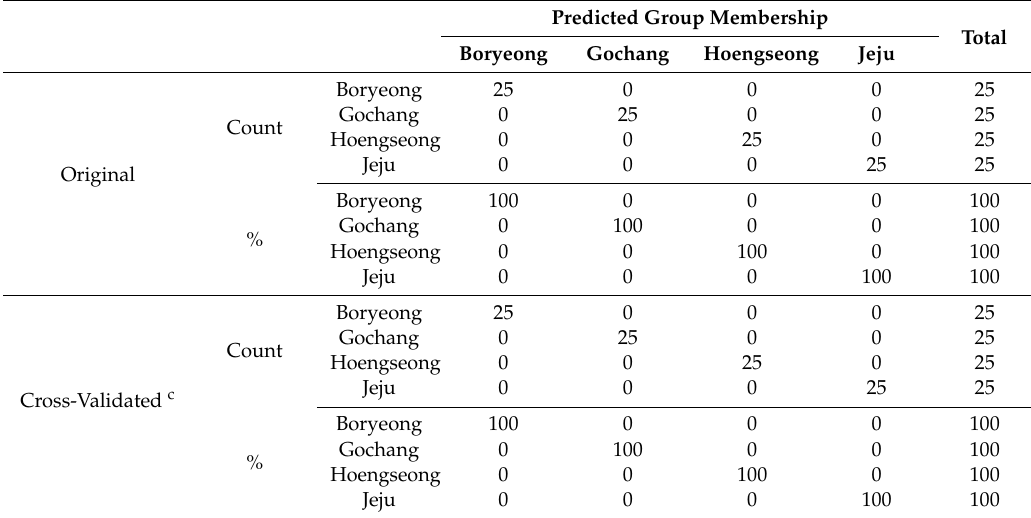
Table 3. Classification and cross-validated results a,b of organic milk (OM) geographical identification in Korea by stepwise discriminant analysis